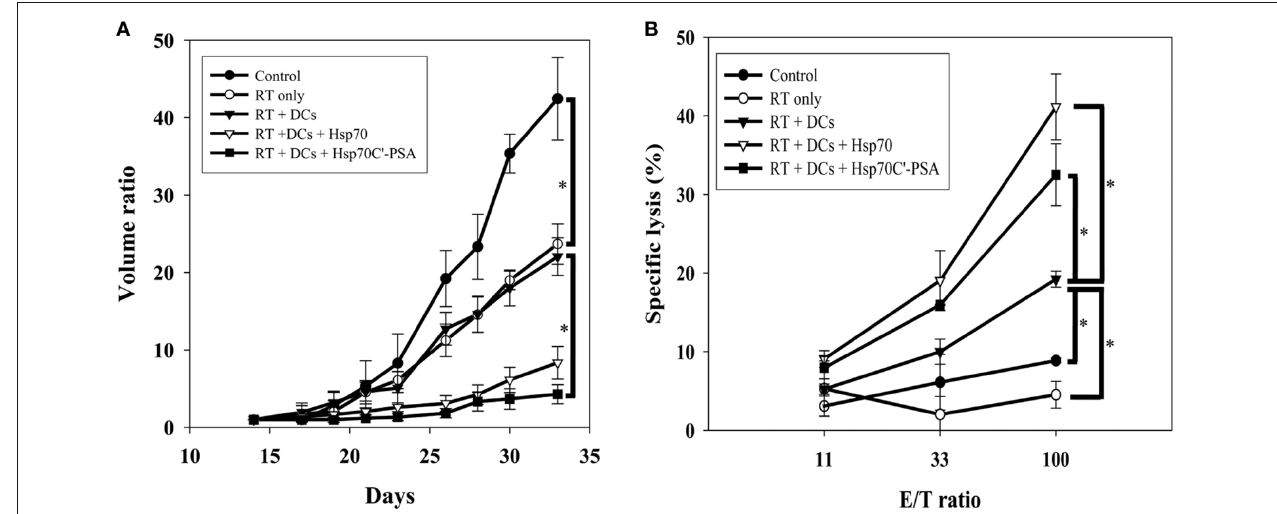
FIGURE 3 | Tumor growth inhibition, tumor-specific CTLs and tumor CD3 + T cell infiltration assay. (A) Mice were injected with 1 × 10 5 CT26/PSA tumor cells s.c. on day 0 and treated with 8Gy of RT on day 14 followed by immunotherapy in different groups. Each treatment group included 6 mice. Mean volume ratio, with SD for each group, is plotted vs.